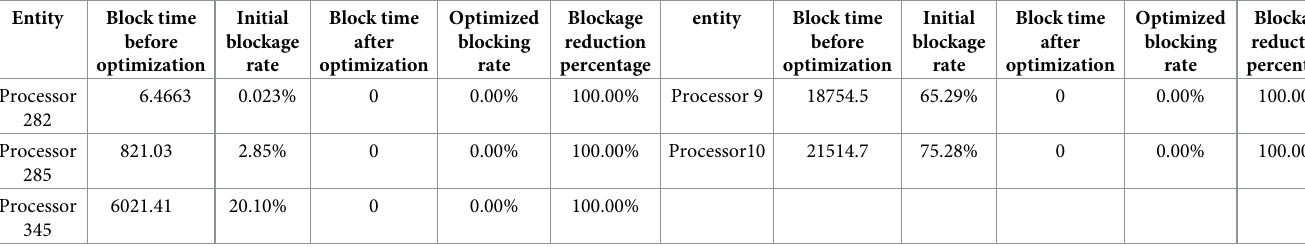
Table 11. Comparison of blocking situation before and after